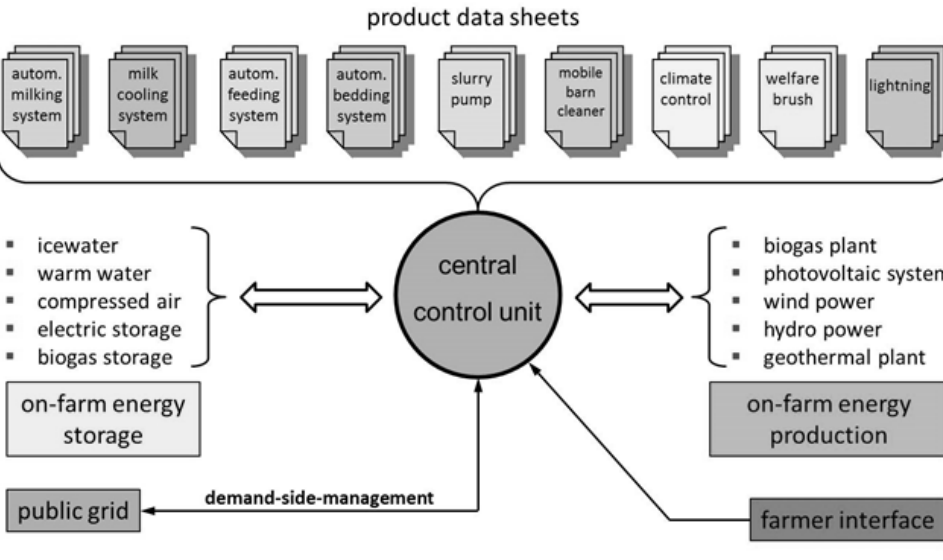
Figure 2. Simulation data for EMS.